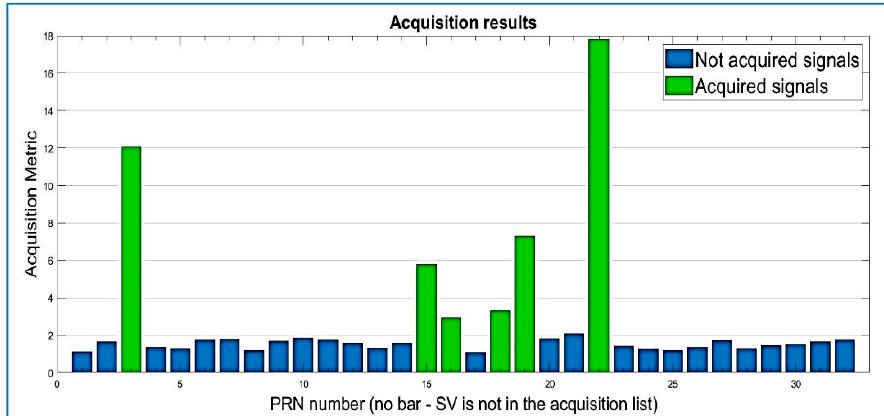
Figure 9. Acquired PRNs from Dataset 1, with R = 0.025.